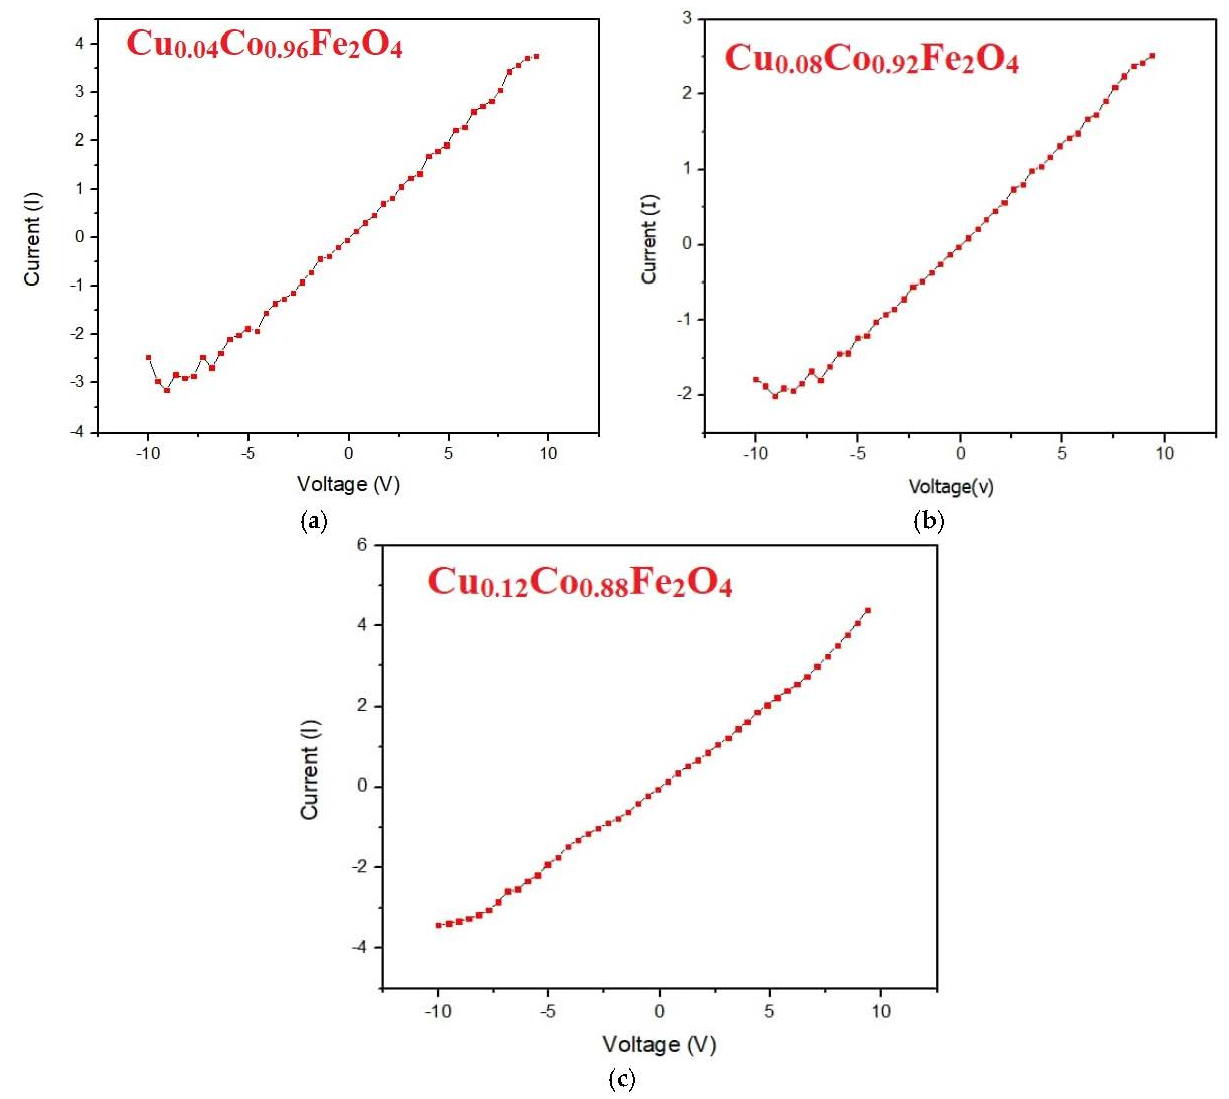
Figure 5. I–V characteristics of CFO NPs doped with different concentrations of Cu 2+ ions. ( a )